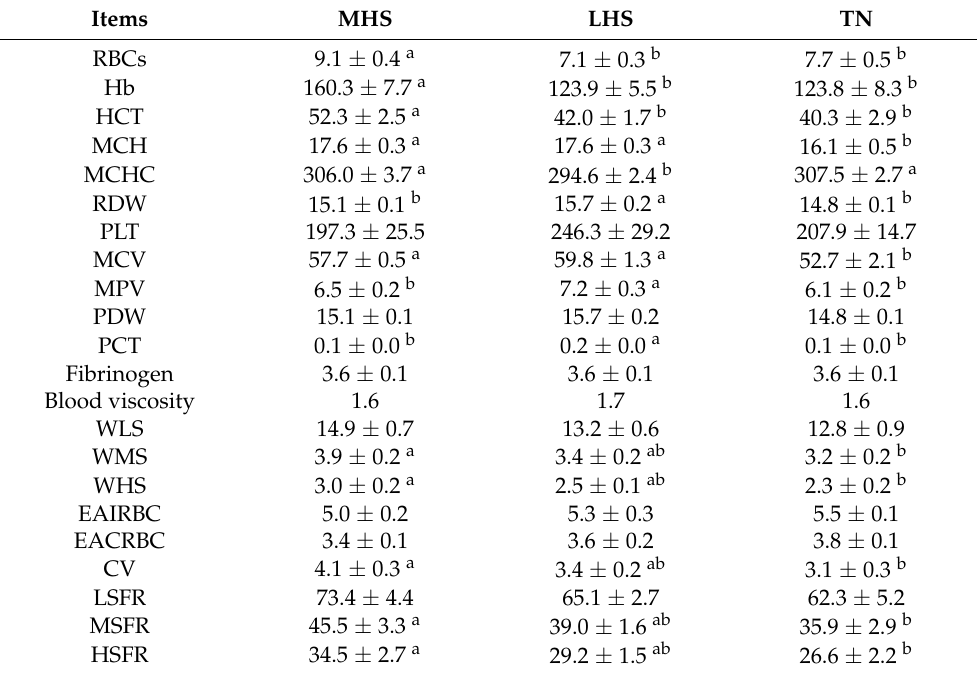
Table 2. Hematologic parameters of yaks under TN, LHS, and MHS